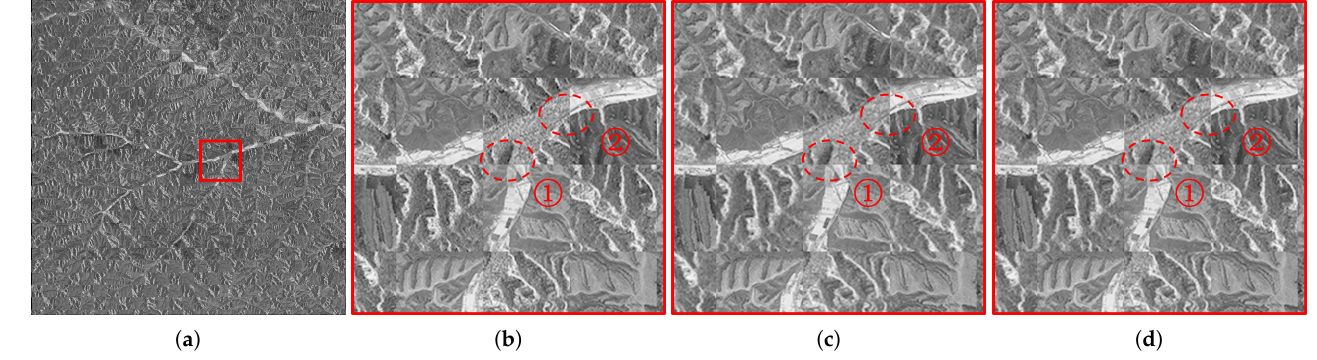
Figure 18. Checkboard mosaic image and enlarged sub-images of Pair A: ( a ) checkboard mosaic image of HOPES; ( b – d ) enlarged sub-images of HOPES, CFOG,